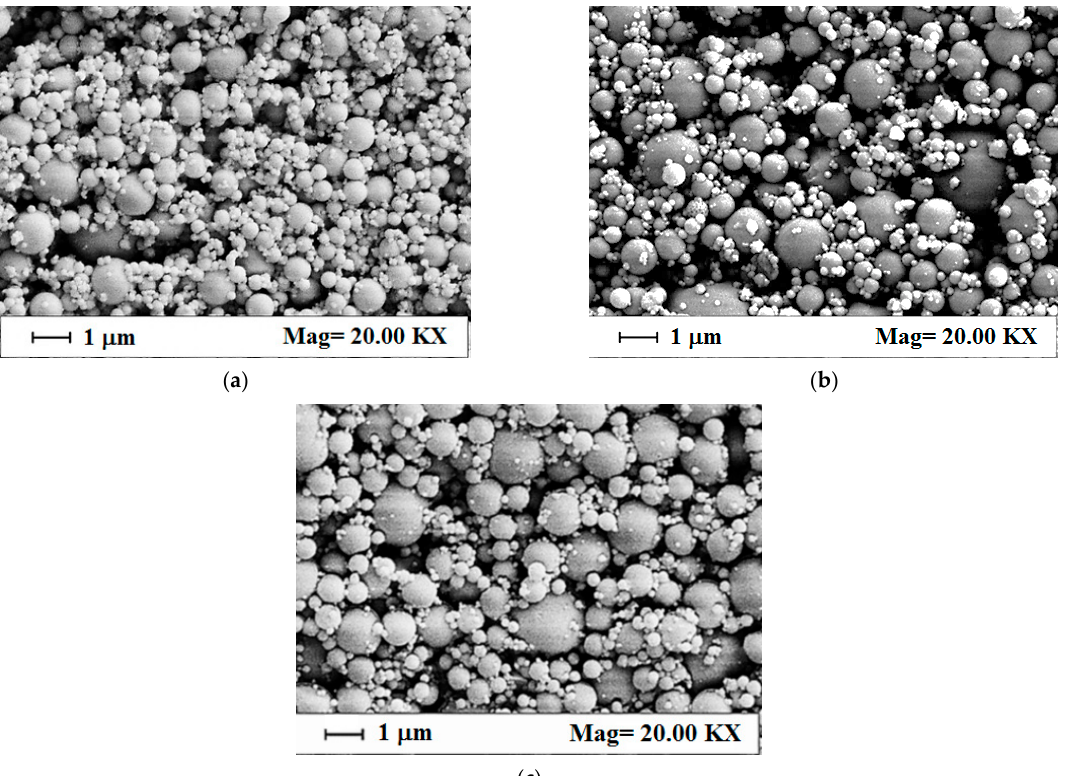
Figure 2. SEM images of sodium alginate microparticles produced via SAA at 80 °C, 82 bar, and GLR = 1.8: ( a ) 5 mg/mL, ( b ) 10 mg/mL, and ( c ) 20 mg/mL.